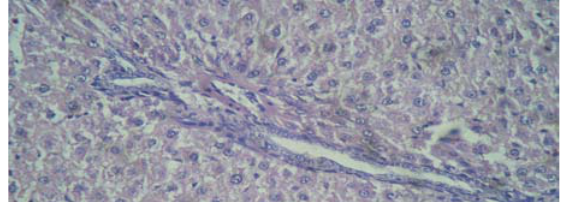
Fig 4. Photomicrograph of liver of paracetamol-treated control rats, arrow shows lymphocytic infiltration (× 400)